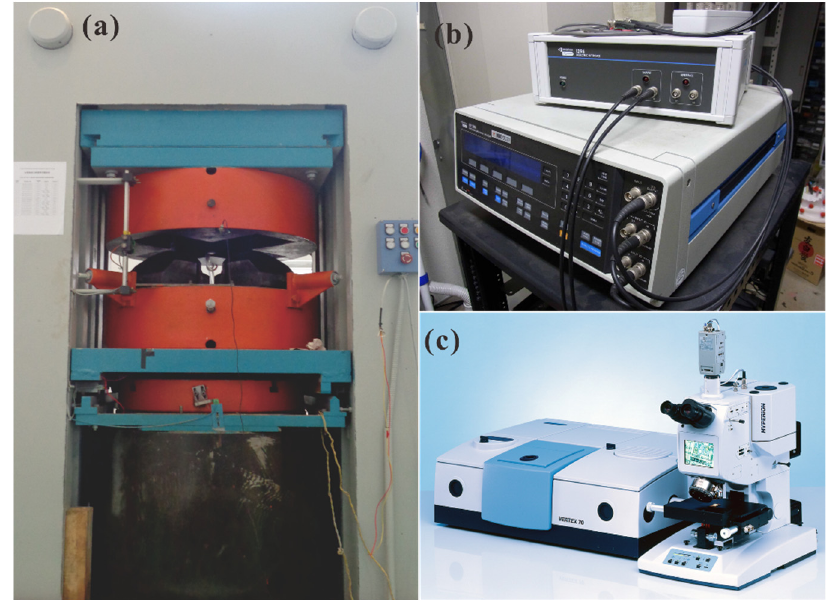
Figure 1. High-pressure experimental platform for the measurements of electrical properties of minerals and rocks using the electrochemical AC impedance spectroscopy in HTHPSEI, Institute of Geochemistry, Chinese Academy of Sciences. In here, ( a ) stands for the YJ-3000t multi-anvil apparatus, ( b ) stands for the combined interface of Solartron-1260 and Solatron-1296 Impedance/Gain-phase analyzers, and ( c ) stands for the Vertex-70V vacuum high-resolution and high-precision FT-IR analyzer, respectively.